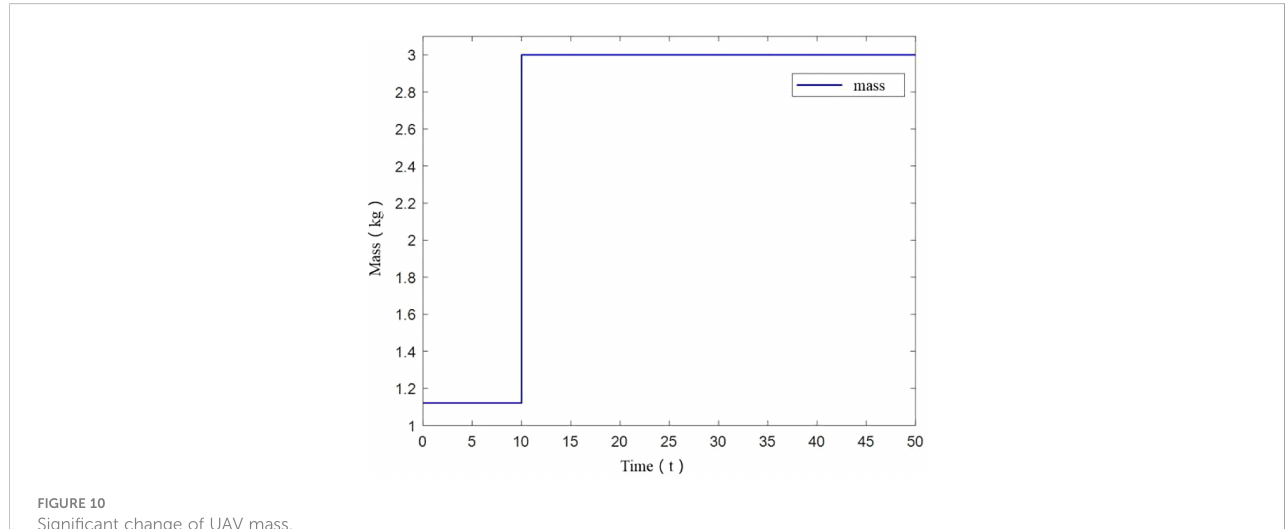
FIGURE 10 Signi fi cant change of UAV mass.